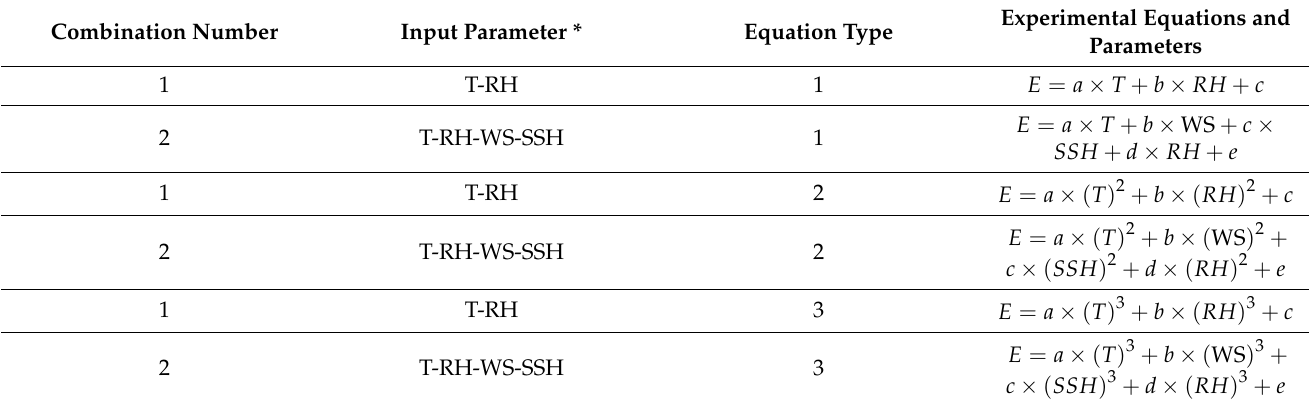
Table 1. Input combinations and relationships were applied to simulate pan evaporation.